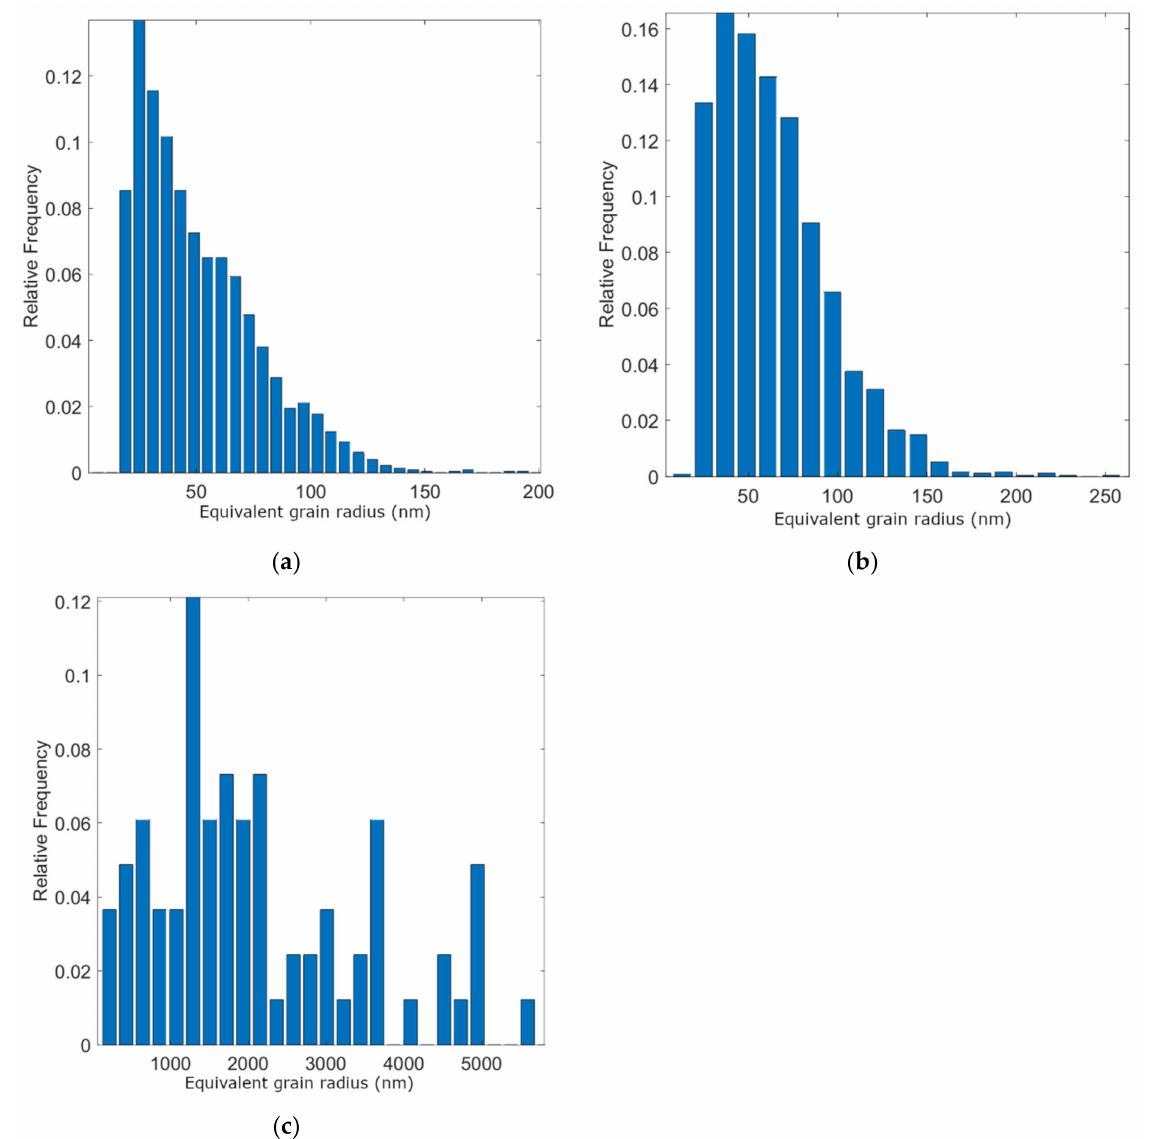
Figure 5. Histograms of distributions of grain sizes of the received samples (based on SEM micro- graphs presented in the Figure 4): ( a ) melted in a ceramic crucible at 1000 ◦ C, quenched by twin rollers method at 1000 RPM; ( b ) melted in ceramic crucible at 1000 ◦ C, quenched by twin rollers method at 800 RPM; ( c ) melted in PtIr crucible at 1000 ◦ C, quenched by twin rollers method at 1000 RPM. Ordinate axis presents the relative frequency of occurrence of grains of a certain radius, and the equivalent grain radius value (nm)